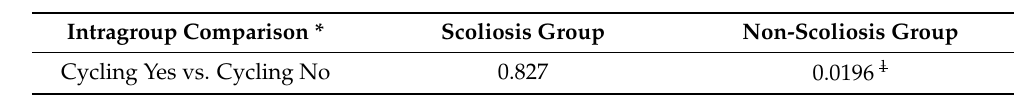
Table 5. p values based on cycling